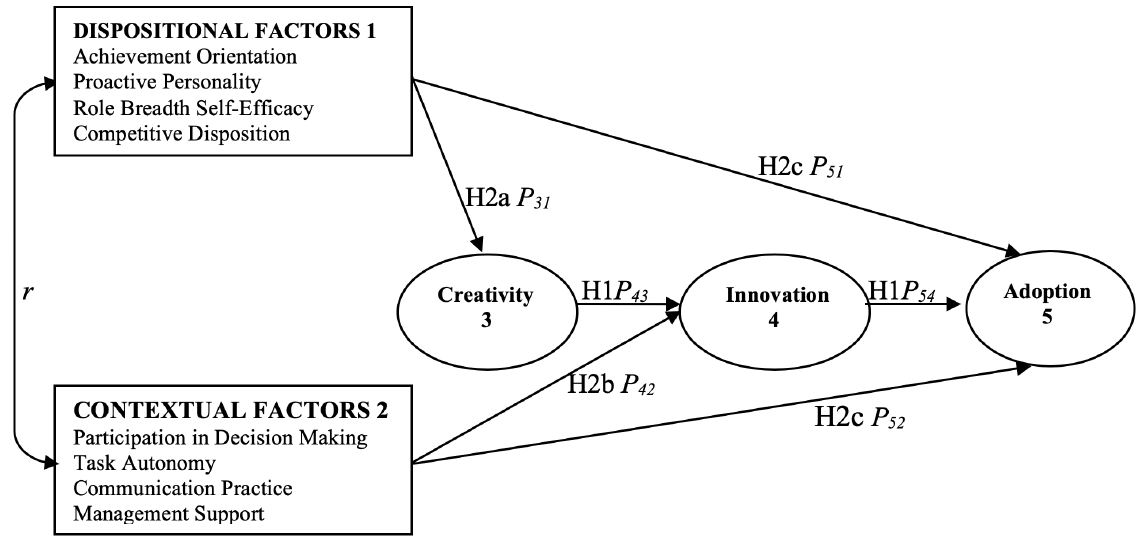
Fig. 1. Integrated model of employee innovation process showing the hypothesised phases and their antecedent